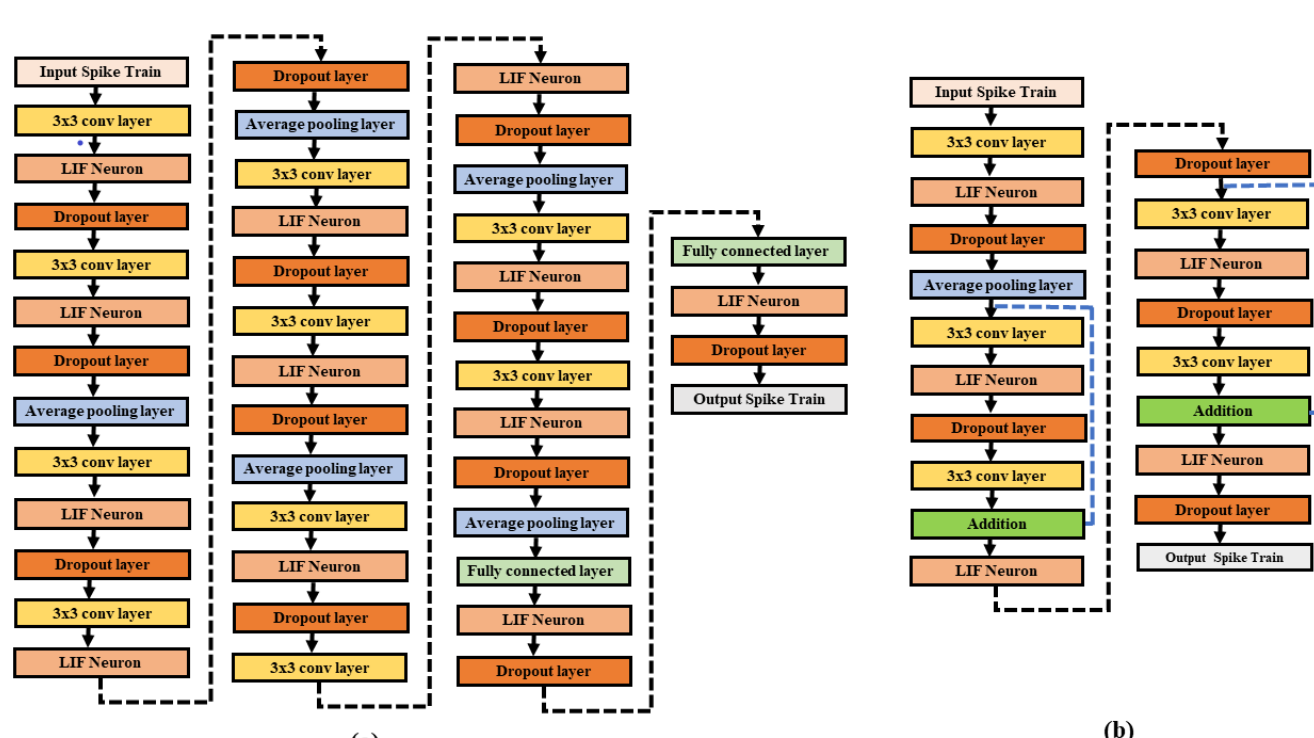
Figure 3. Network Architectures: ( a ) VGG-13 ( b )